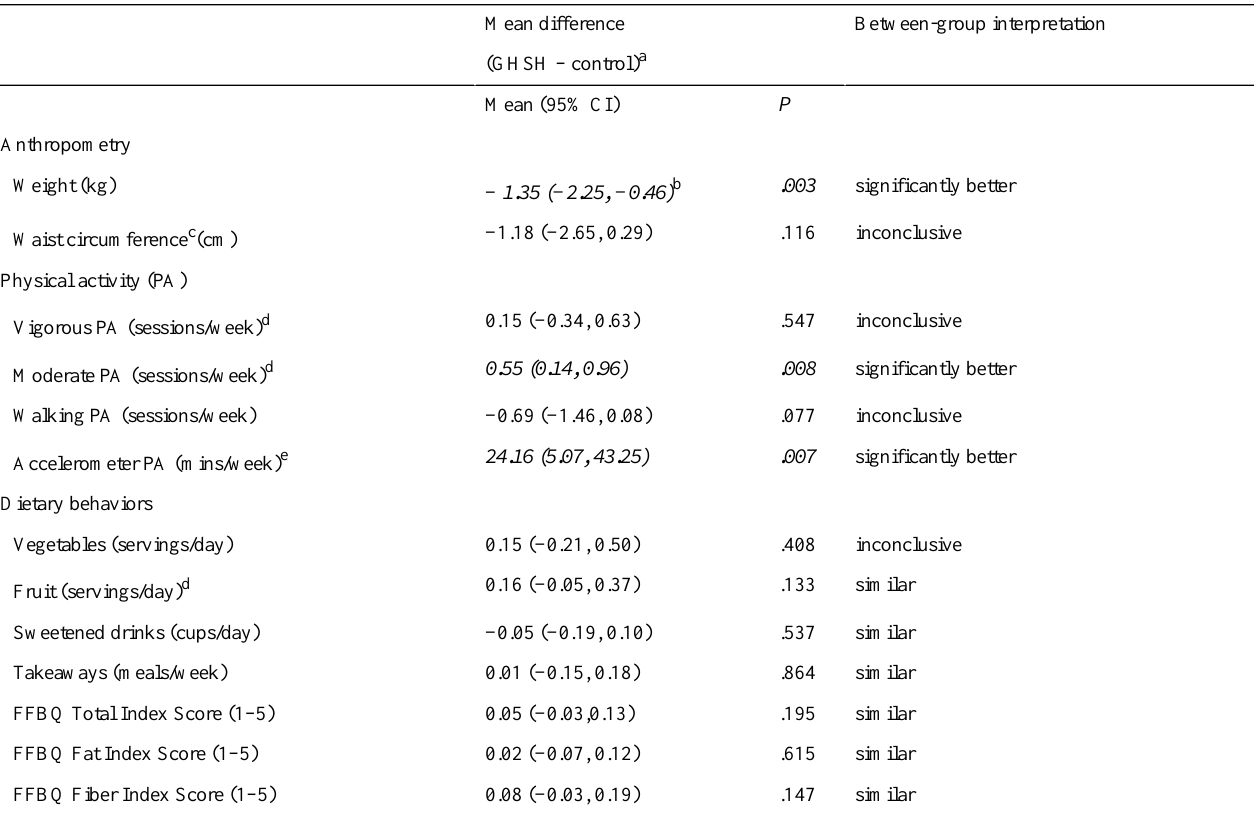
Table 3. Mean differences in changes between the ‘Get Healthy, Stay Healthy’(GHSH) intervention (I; n=104) and control groups (C; n=114).